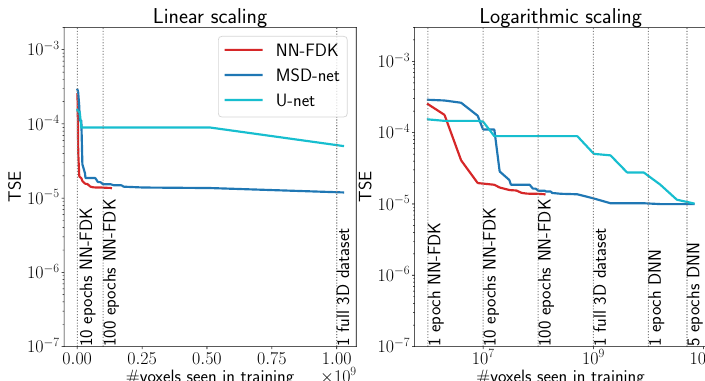
Figure 5. The test set error (TSE) as a function of the number of voxels the training process has seen. We report the lowest TSE until that point. The networks are trained on randomly generated Fourshape phantoms with size N = 1024, N a = 32 projection angles and no noise. ( Left ) Linear scaling in the number of voxels ranging from 1 epoch for the NN-FDK (10 6 voxels), to one full 3D dataset (10 9 voxels). ( Right ) Logarithmic scaling in the number of voxels. Ranging from 1 epoch for the NN-FDK network (10 6 voxels) to 5 epochs for a DNN (5 10 10 voxels). ×